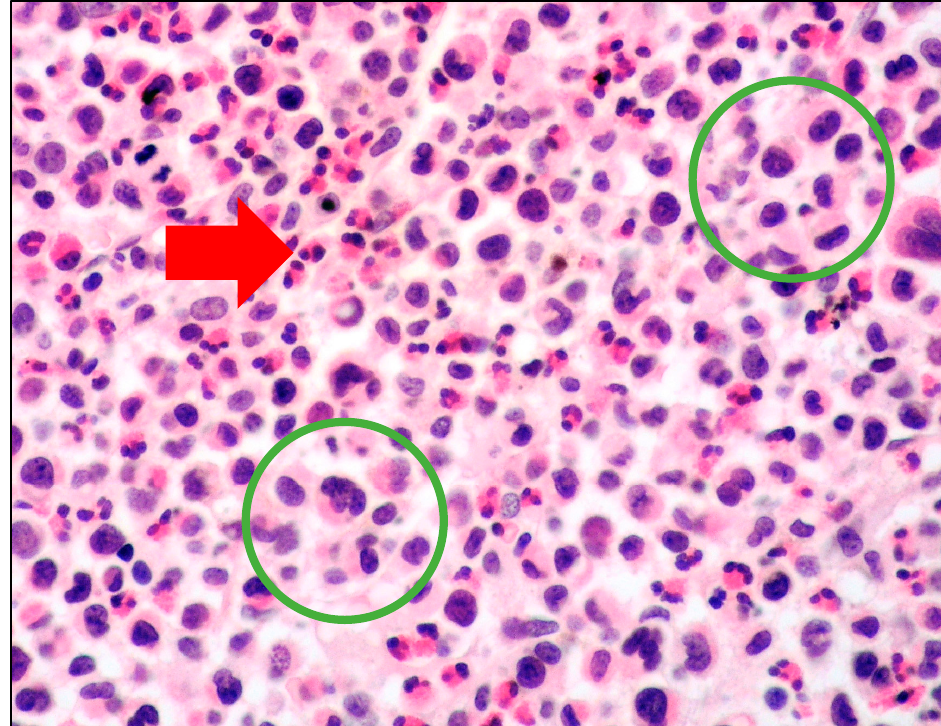
Figure 2. High-power view of BM biopsy diffusely infiltrated by atypical cells with pleomorphic nuclei (within green circles); in the background, numerous eosinophils were found (red arrow) (hematoxylin and eosin, magnification 400×; original image from Prof. S.A.